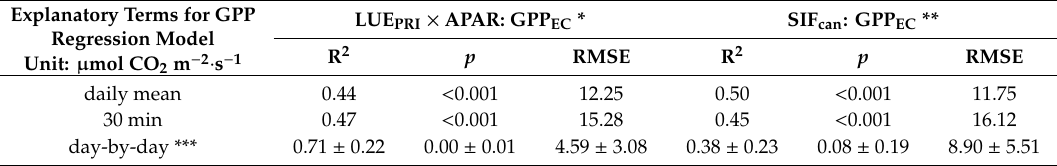
Table 1. Summary statistics of the photochemical reflectance index (PRI)-based light use efficiency (LUE) model and solar-induced fluorescence (SIF)-based linear model for gross primary production (GPP) estimation at different time scales.